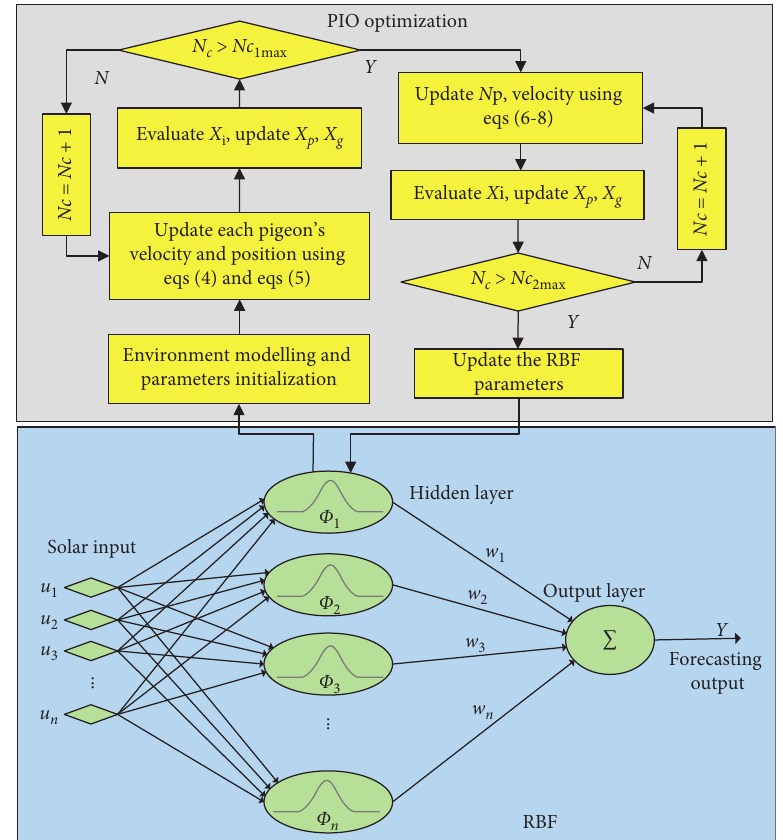
Figure 1: Procedure of PIO-optimized RBF